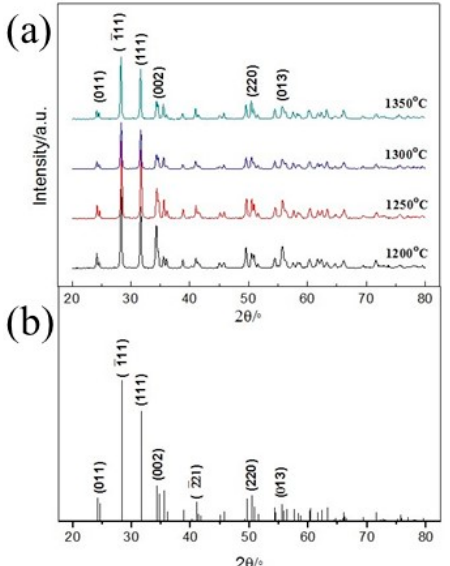
Figure 2. XRD patterns of HfO 2 coatings deposited at different temperatures. ( a ) is the XRD diagram of HfO 2 and ( b ) is standard XRD spectrum of HfO 2 .